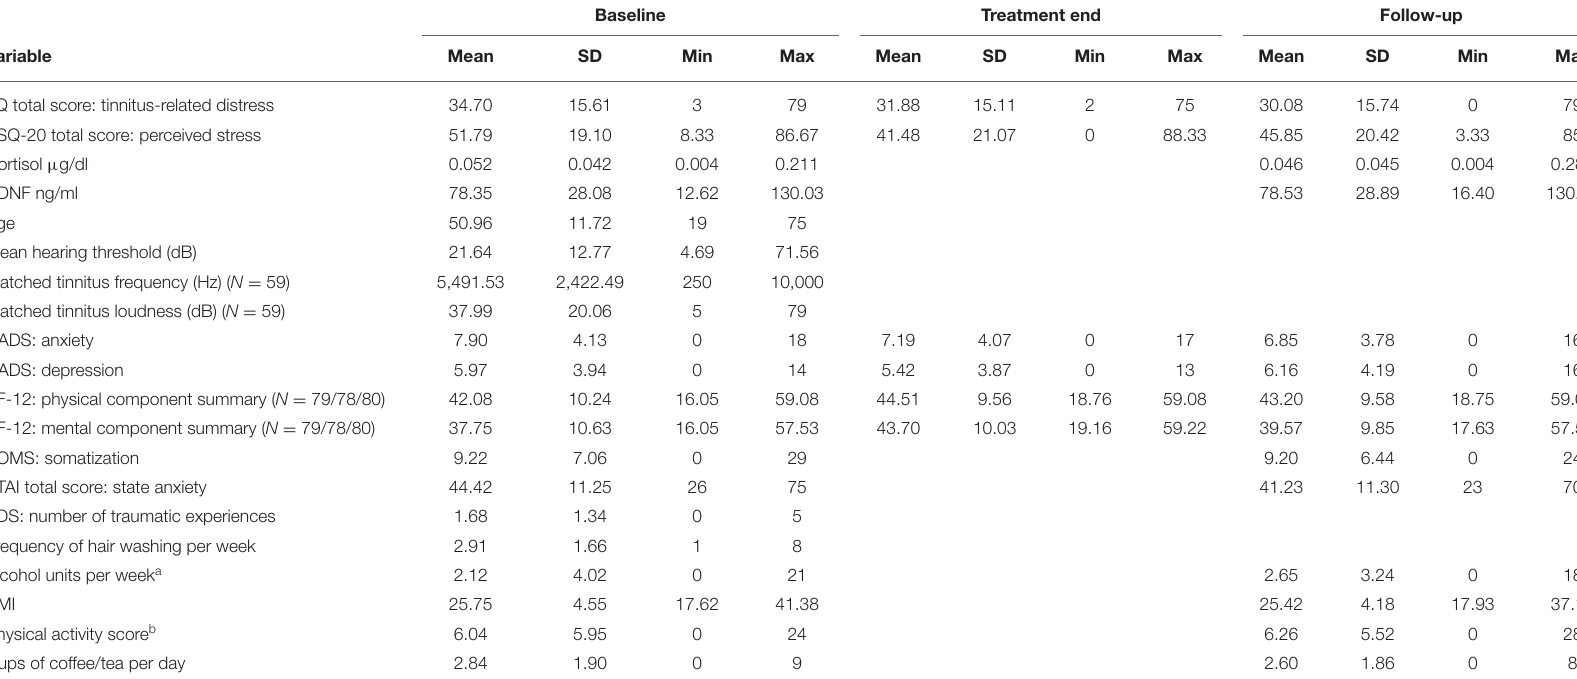
TABLE 1 | Summary statistics of numeric variables ( N = 80). Baseline Treatment end